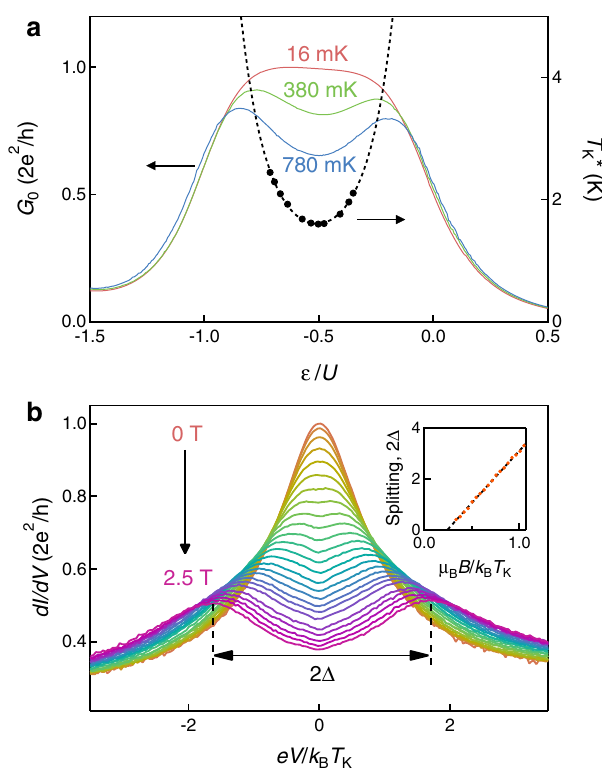
Fig. 2 Energy level and magnetic- fi eld dependence of the Kondo state. a ε / U dependence of G 0 for three temperatures (16, 380, and 780mK). The experimental T (cid:5) shown on the right axis is fi tted with the formula shown in K ref. 35 . b Differential conductance at the PHS point as a function of eV / k B T K for different magnetic fi elds from 0 to 2.5T with 0.1T steps. Here, the lowest fi eld 0.1T is de fi ned as 0T (see text). (inset) 2 Δ , which is the width of Zeeman splitting, as a function of μ B B / k B T K